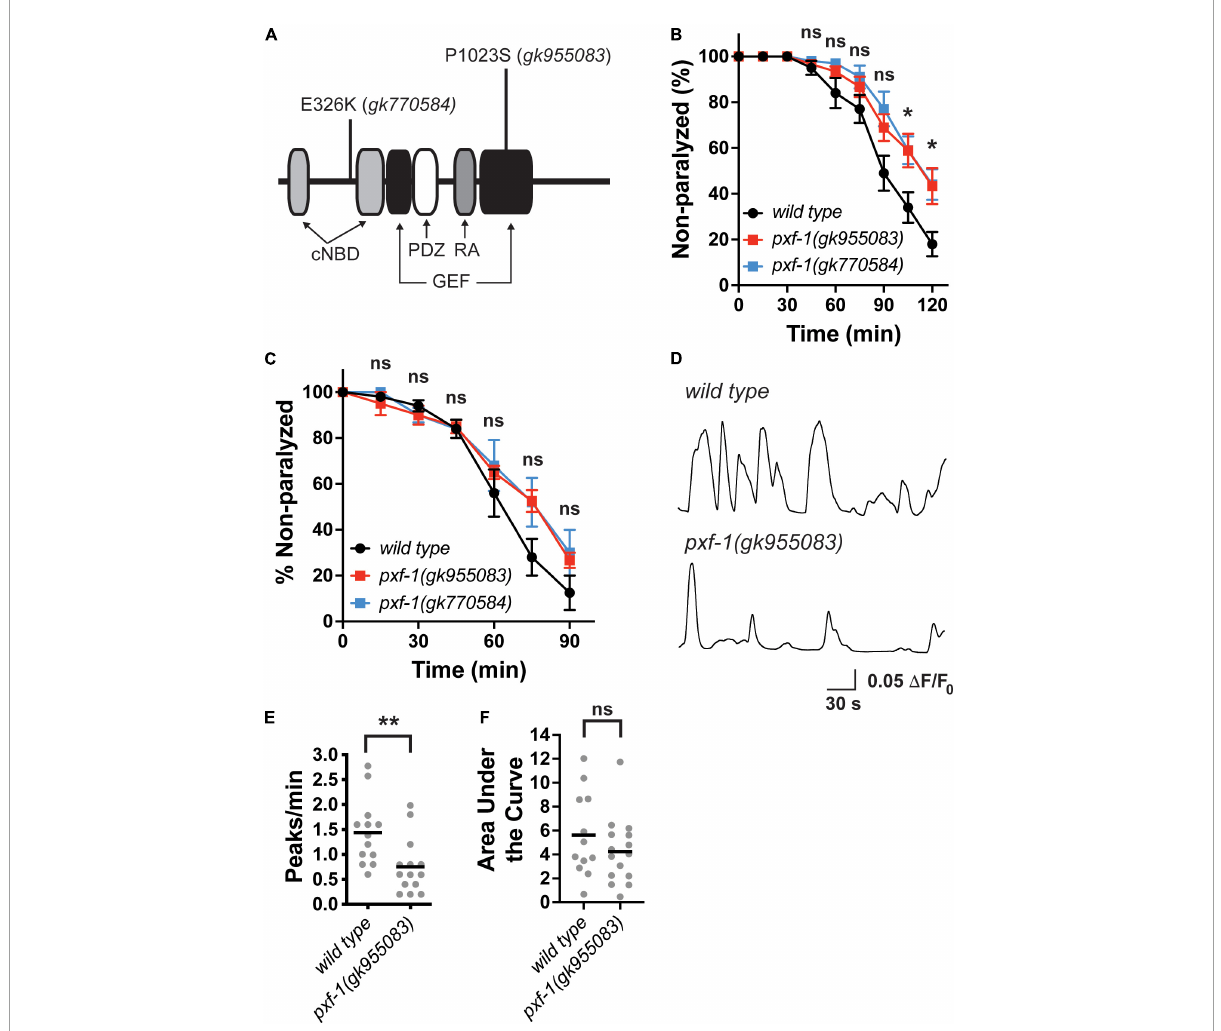
FIGURE1 Aldicarb sensitivity and postsynaptic calcium transients are reduced in pxf-1 mutant animals. (A) Diagram of predicted PXF-1 protein. The gk955083 and gk770584 alleles are indicated above the protein. The predicted functional domains and motifs are indicated below the protein. cNBD is a cyclic nucleotide-binding domain, GEF is a guanine nucleotide exchange factor domain, PDZ is PSD95/Disk Large/ZO-1 domain, and RA is a Ras interacting domain. (B) Quantification of non-paralyzed animals during 120 min on 1 mM aldicarb. Dots indicate means, and error bars indicate the SEM. n = 7–10 trials. * p < 0.05 or ns = not significant between either mutant and wild type animals at each timepoint. (C) Quantification of non-paralyzed animals during 90 min on 0.5 mM levamisole. Dots indicate means, and error bars indicate the SEM. n = 4–5 trials. ns = not significant at each timepoint. (D) Representative traces of GCaMP intensity in dorsal muscles in animals immobilized with polystyrene beads. Peaks greater than 0.05 (cid:49) F/F 0 were analyzed in panels (E,F) (E) Quantification of the number of peaks per minute. Gray dots indicate individual animals, and black bars indicate the means. n = 12–15 animals. ** p < 0.01. (F) Quantification of the area under each peak. Gray dots indicate individual animals, and black bars indicate the means. n = 12–15 animals. ns, not